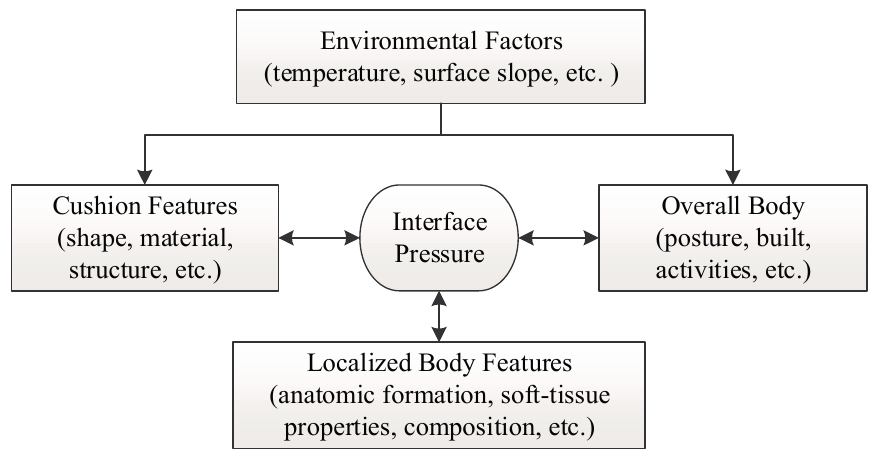
Figure 1. The factors interactively influence interface pressure